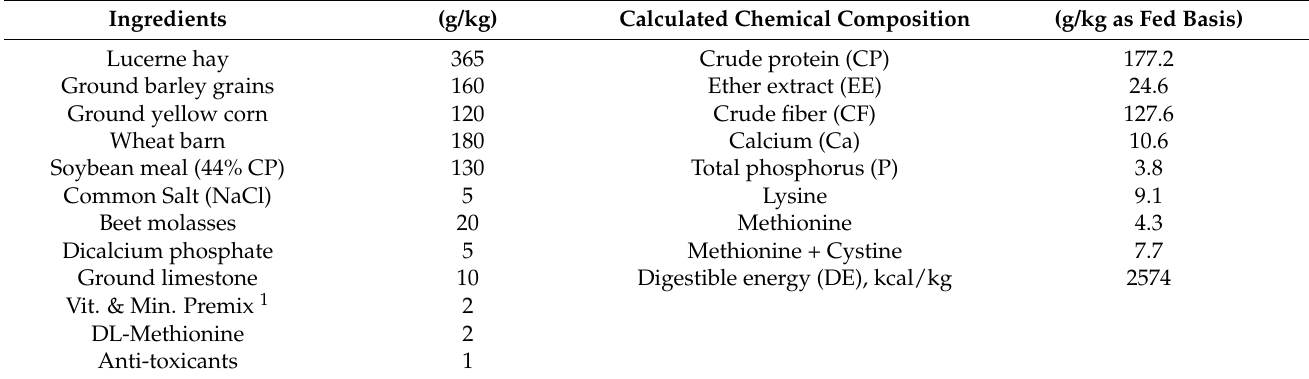
Table 1. The ingredients and calculated chemical composition of the experimental diet.